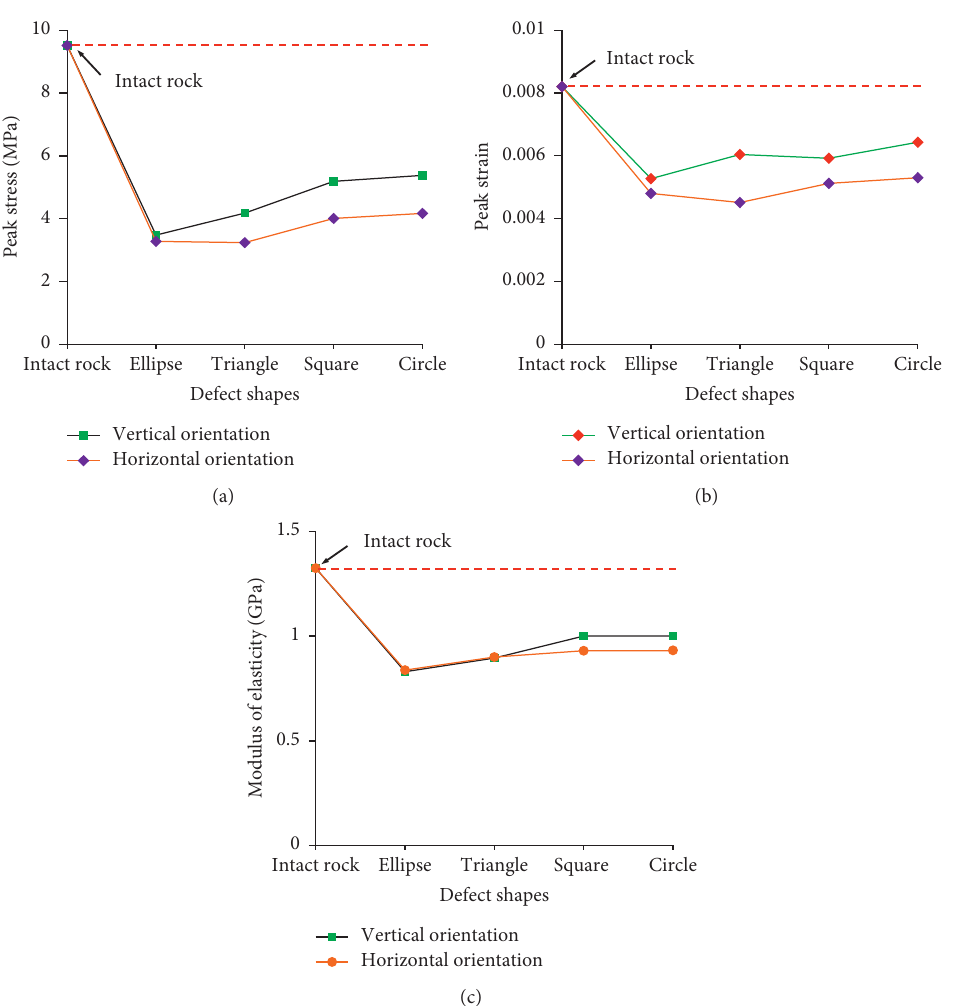
Figure 7: Mechanical properties of vertical orientation and horizontal orientation models. (a) Peak stress. (b) Peak strain. (c) Elastic